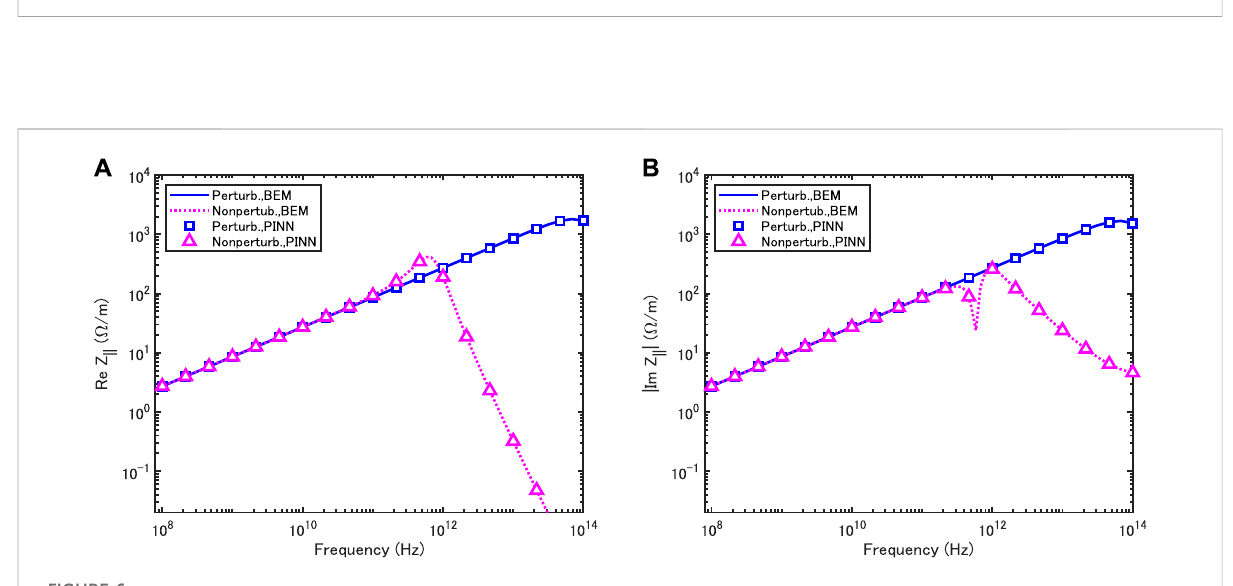
FIGURE 6 Comparison of the perturbative and nonperturbative models in the coupling impedances of a round Gaussian beam with σ r = 0.5 mm moving on the axis of a circular vacuum chamber with in fi nite thickness for NEG. The NEG chamber has radius of 5 mm. Real part (A) and imaginary part (B)